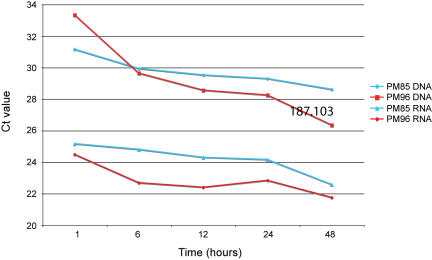
The association of levels of PCR amplifiable human nuDNA and RNA with digestion time.Note that in conventional quantitative real-time PCR assays, the measure of PCR amplifiable DNA or RNA (the Ct value) is inversely related to the starting concentration of template. Therefore, lower Ct values indicate higher original PCR amplifiable DNA or RNA yields.